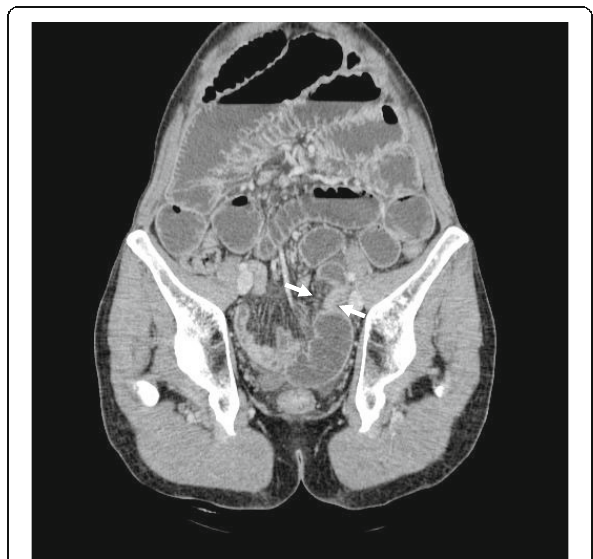
Fig. 3 Reconstructed oblique coronal image of MDCT showed the constricted part of the intestine and the converged mesentery (arrows), reflecting the position of the hernia